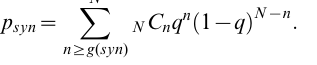
Figure S1 Gene expression states in PEV strains assessed by time-lapse imaging of single yeast cells. (A) Schematic illustration of the yeast strains expressing EGFP. Time-lapse images of the Euchromatin (FUY259) (B), ty5 D :: NLS-3xEGFP (FUY260) (C), same as Figure 2. Figure S2 Position effects at Telomer, HMR -right, HML -right by ADE2 colony assay with disruption strain of histone modification enzyme. Position effect of ADE2 expression results in variegated colonies when inserted at the telomere, HMR -left, HMR -right, and HML -right in the sir3 D , sas2 D , gcn5 D , eaf3 D , and dot1 D strains. A colony color assay was performed using cells carrying telomere-linked ADE2 ((B) TEL-VR PEV (FUY328), (F) TEL-VR PEV + sir3 D (FUY339), (J) TEL-VR PEV + sas2 D (FUY344), (N) TEL-VR PEV + gcn5 D (FUY789), (R) TEL-VR PEV + eaf3 D (FUY812), (V) TEL-VR PEV + dot1 D (FUY818)), HMR right-linked ADE2 ((C) HMR -right PEV (FUY331), (G) HMR -right PEV + sir3 D (FUY342), (K) HMR -right PEV + sas2 D (FUY347), (O) HMR -right PEV + gcn5 D (FUY792), (S) HMR -right PEV + eaf3 D (FUY815), (W) HMR -right PEV + dot1 D (FUY821)), and HML right-linked ADE2 ((D) HML -right PEV (FUY784), (H) HML -right PEV + sir3 D (FUY786), (L) HML -right PEV + sas2 D (FUY787)), (P) HML -left PEV + gcn5 D (FUY793), (T) HML -left PEV + eaf3 D (FUY816), (X) HML -left PEV + dot1 D (FUY822)). (A) ade2 (FUY32), (E) ade2 + sir3 D (FUY338), (I) ade2 + sas2 D (FUY343), (M) ade2 + gcn5 D (FUY788), (Q) ade2 + eaf3 D (FUY811), and (U) ade2 + dot1 D (FUY817) were used as controls in this experiment. Freshly grown yeast cells were spread onto SC plates (Adenine 10 m g/ml) and incubated at 30 u C for 2–3 d. The white bar indicates 2 mm. Figure S3 Representative expression lineage trees derived from a single cell. (A) Fluorescence intensity in a cell transformed with HMR -left PEV/TEL-VR PEV/Euchromatin (FUY488) and tracked in real-time. The circle on the upper left side indicates the first single cell, the arrowhead pointing from this circle to the